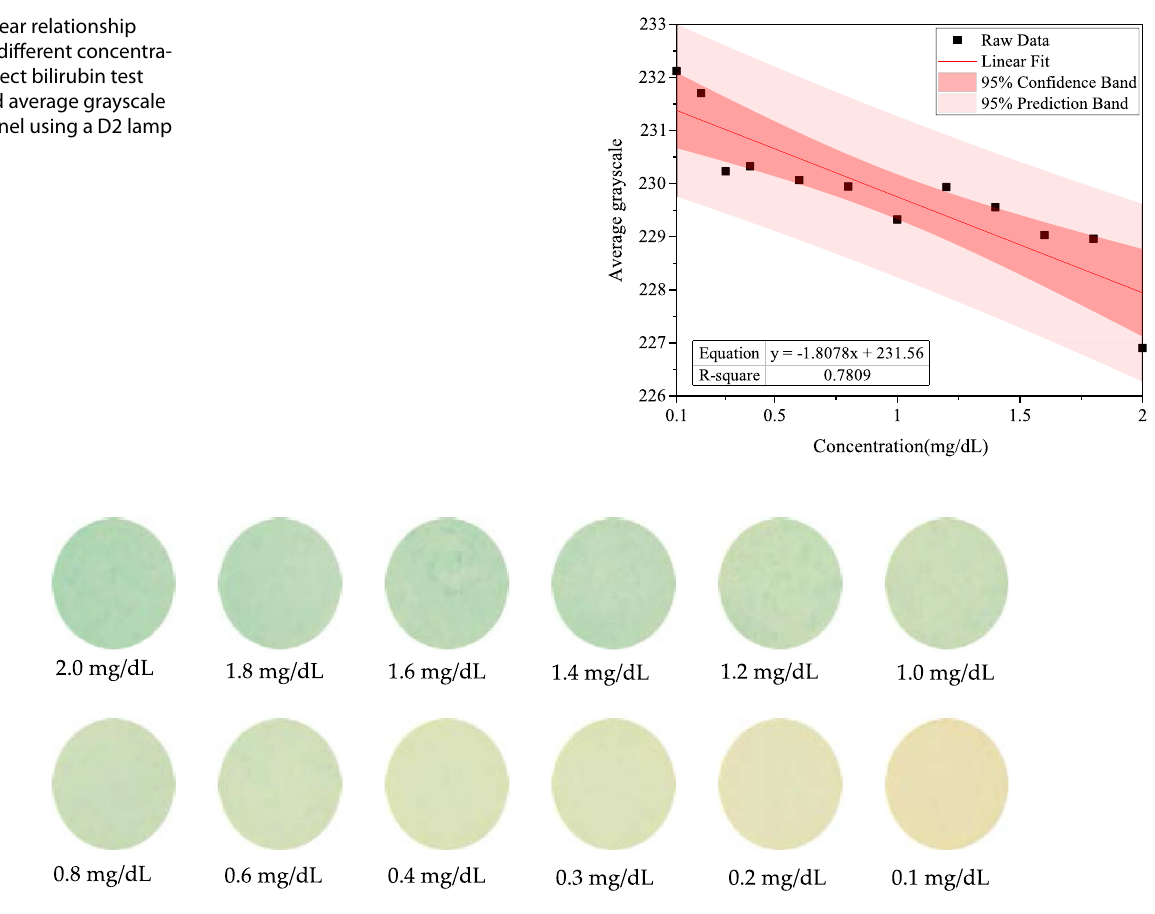
Fig. 8 Color images of test papers with different concentrations of bilirubin while using an H2 lamp as the light